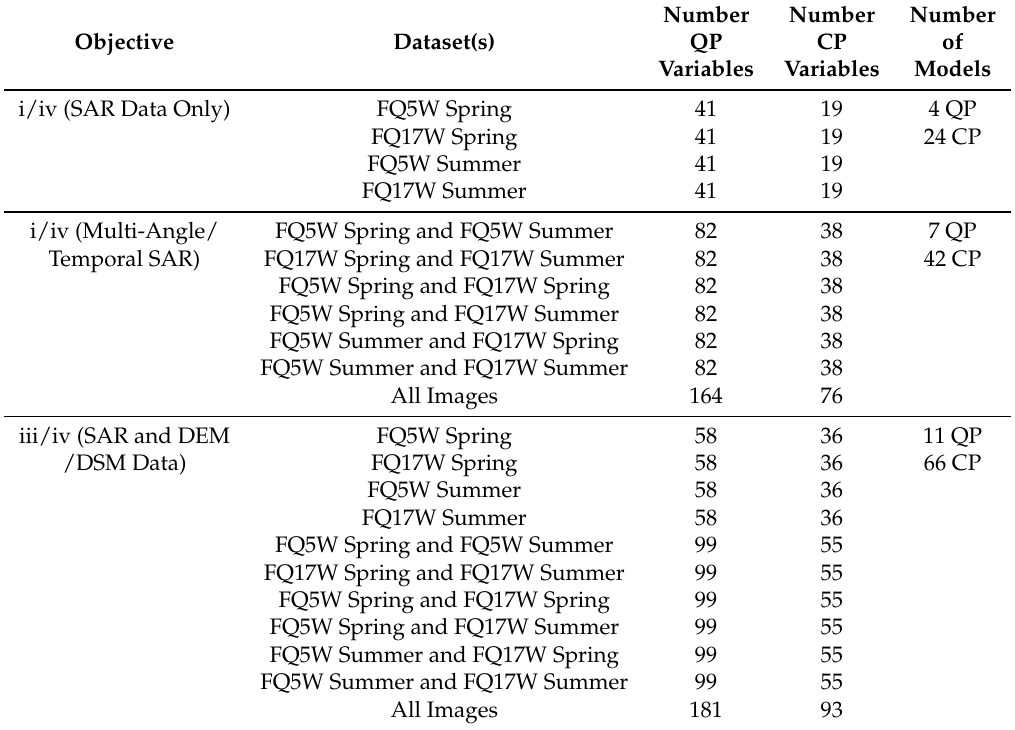
Table 4. List of variables generated from each dataset for use in constructing RF models. Note that the column indicating the total number of models for CP data was calculated based on the number of simulations. For example, for models based on SAR data only, 24 different CP models were generated: for all 4 images × 3 simulations of high resolution data, and 4 images × 3 simulations of medium resolution